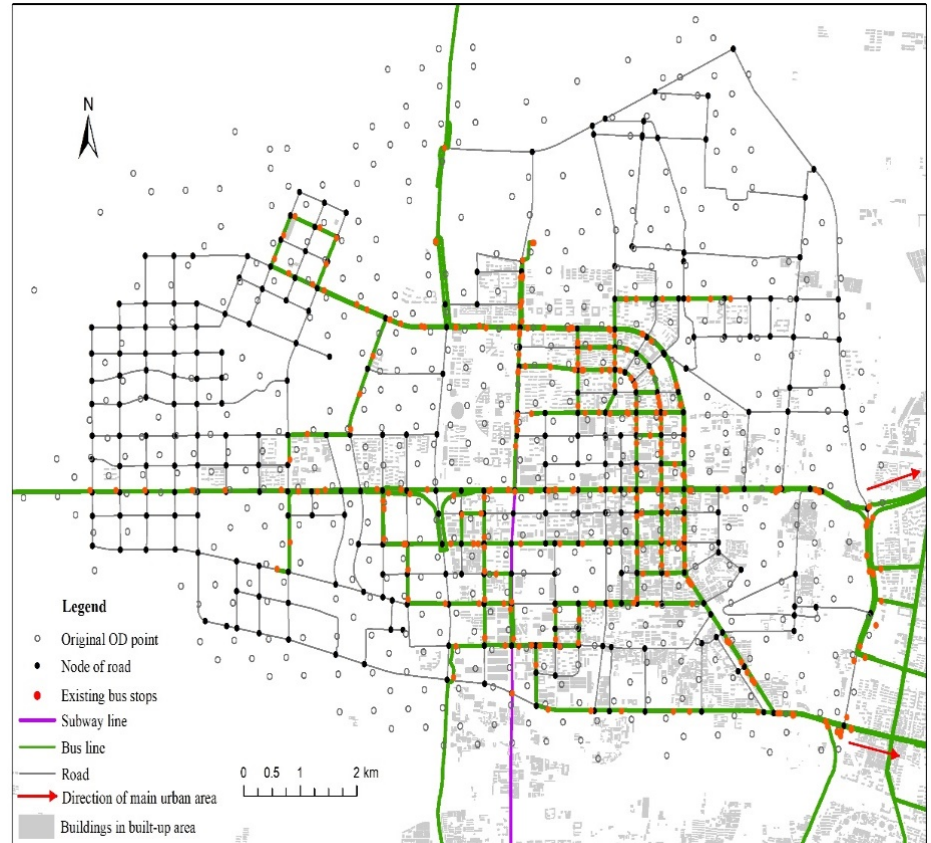
Figure 1. Study area and data.